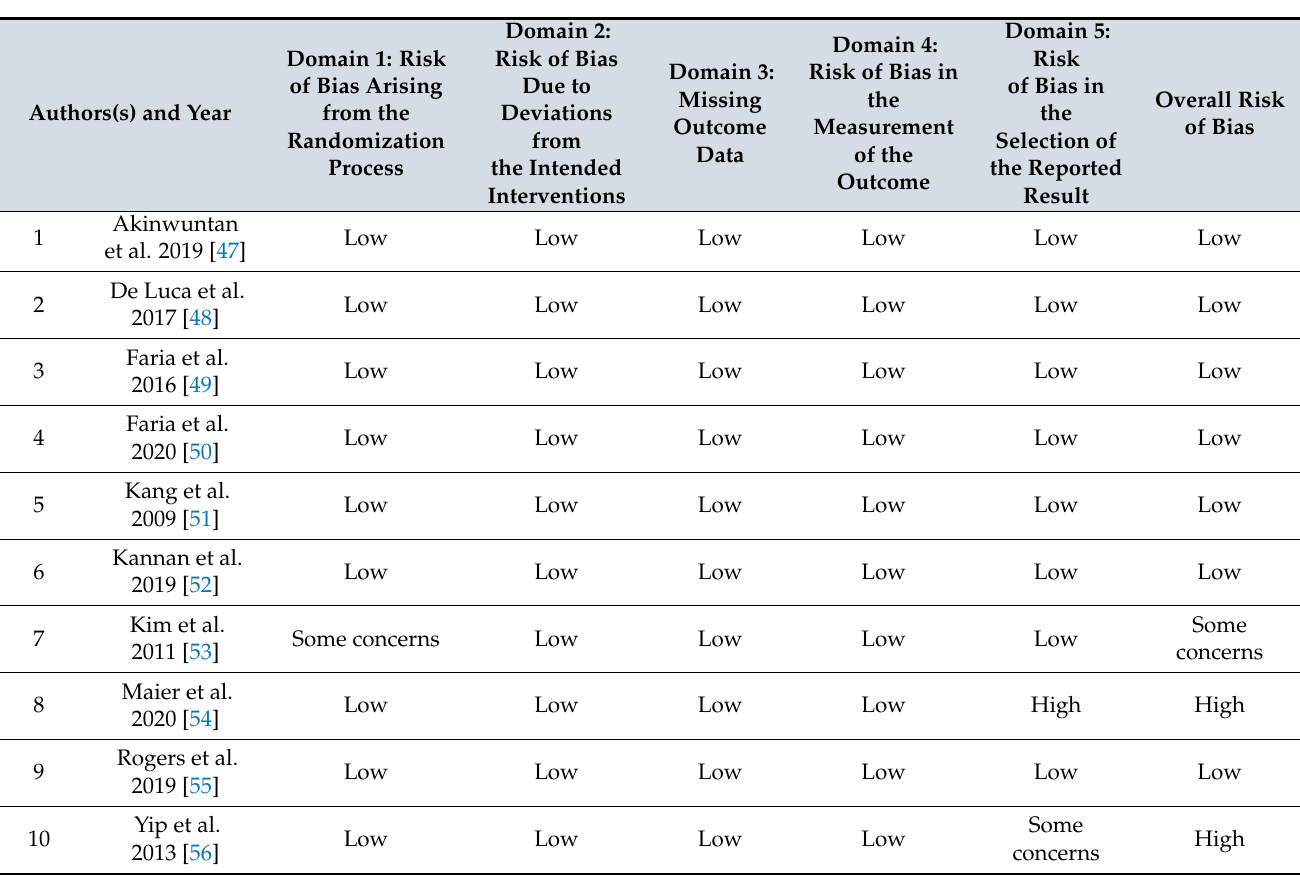
Table 2. Risk of bias